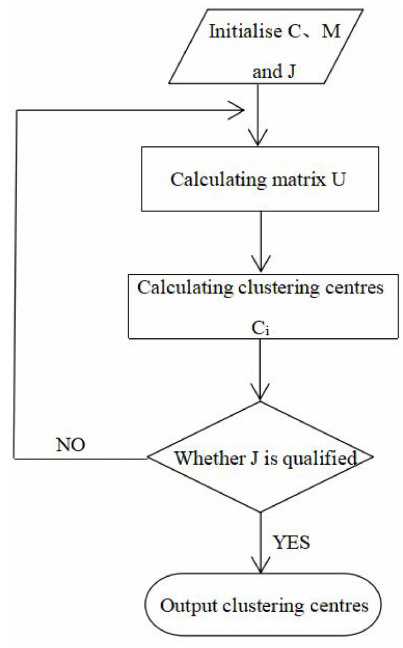
Figure 6. A flowchart of